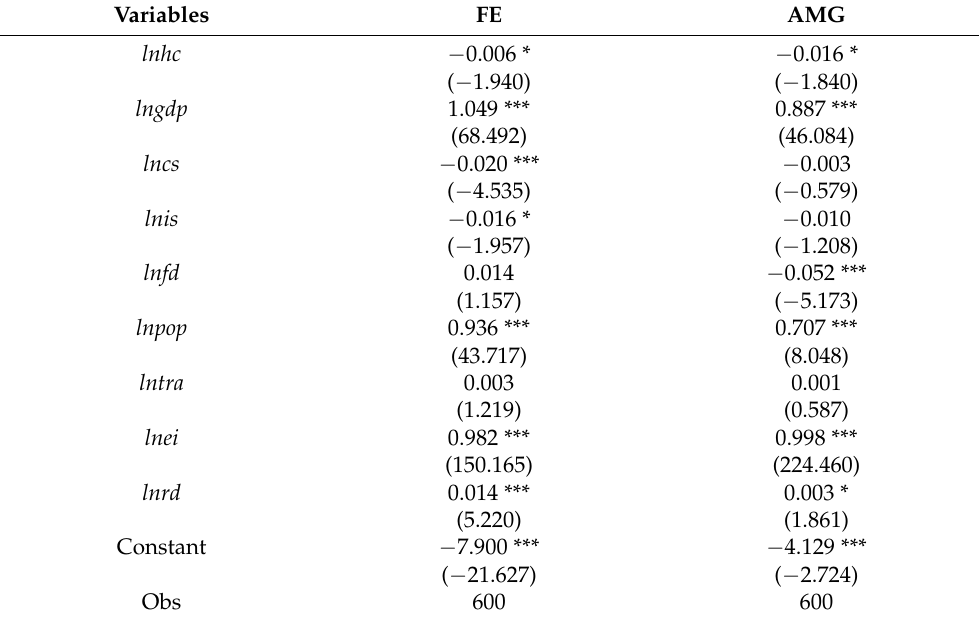
Table 2. Baseline